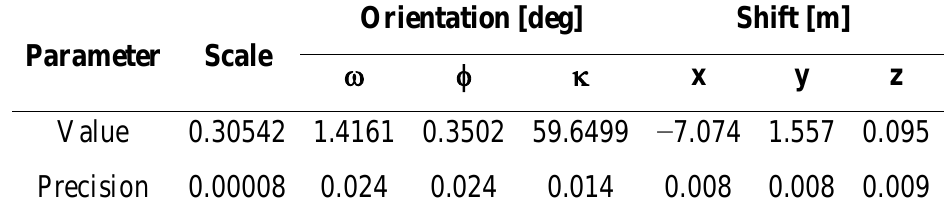
Table 1. Results of a Total Station survey of control targets and corresponding orientation parameters of the LiDAR sensor head compared with respect to the global coordinate